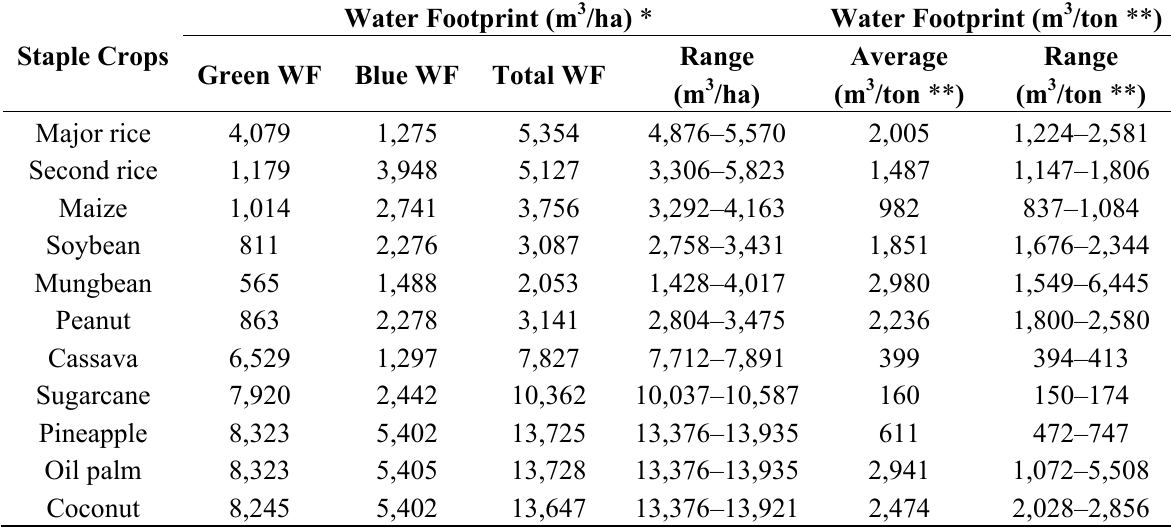
Table 2. Water footprint of the studied crops grown in